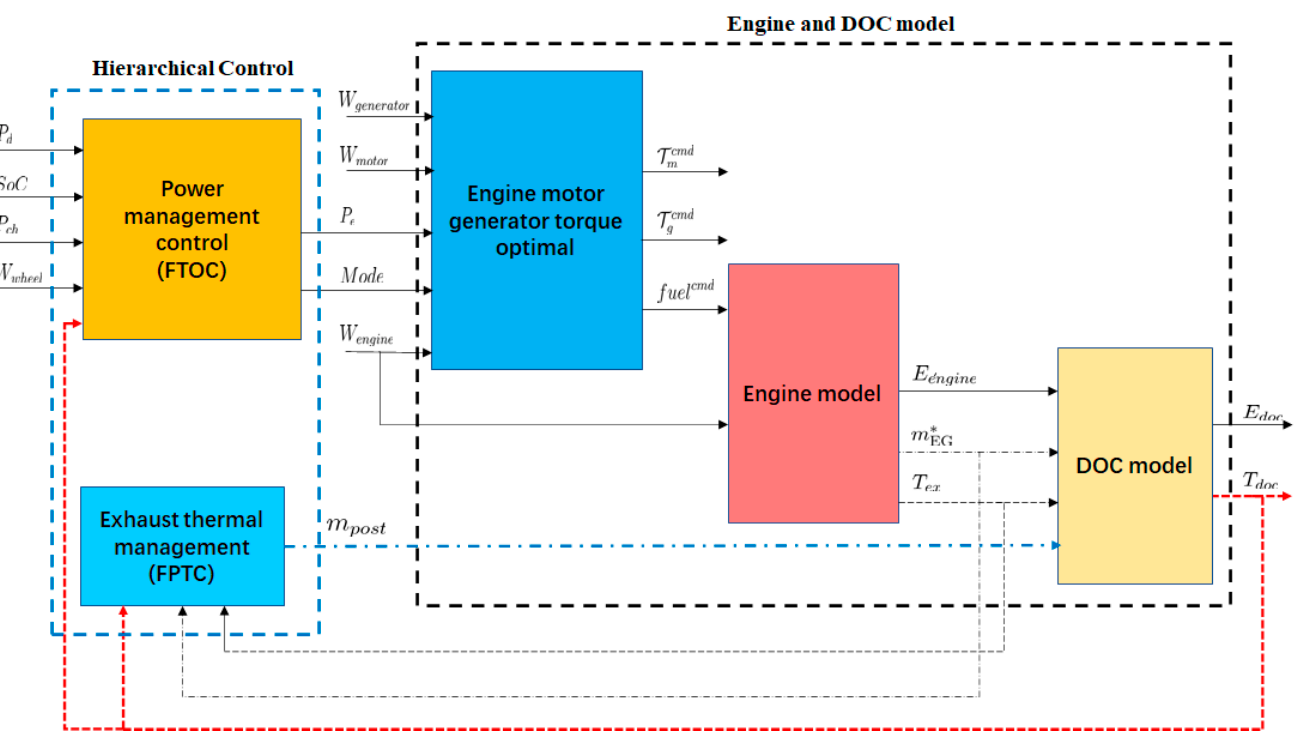
Figure 13. Schematic of hierarchical control for power split and exhaust thermal management (FTOC + FPTC).